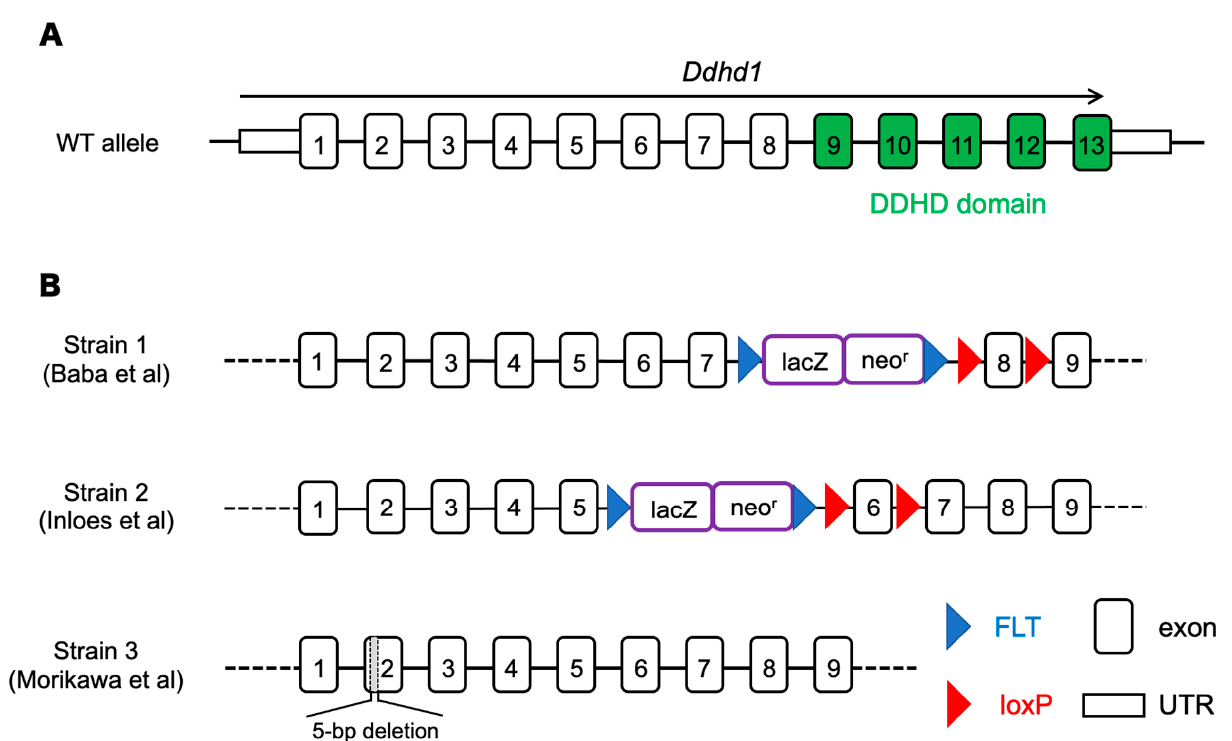
Figure 1. ( A ) The structure of Ddhd1 gene (NM_176845.5). Exons including the region of the DDHD domain that is critical for enzymatic activity are shown in green. ( B ) Ddhd1 knockout mice estab‑ lished previously. Strain 1 and 2 deleted the Ddhd1 gene by inserting a cassette of lacZ and neomycin resistance gene inside an intron [17,24]. In strain 3, Ddhd1 is disrupted by inducing 5 bp deletion to induce premature termination [23]. The map is not drawn to